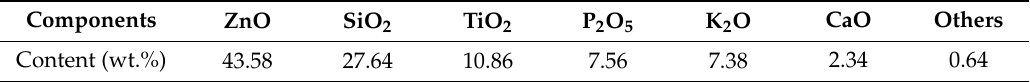
Table 1. The analyzed components of the low-melting-point glass